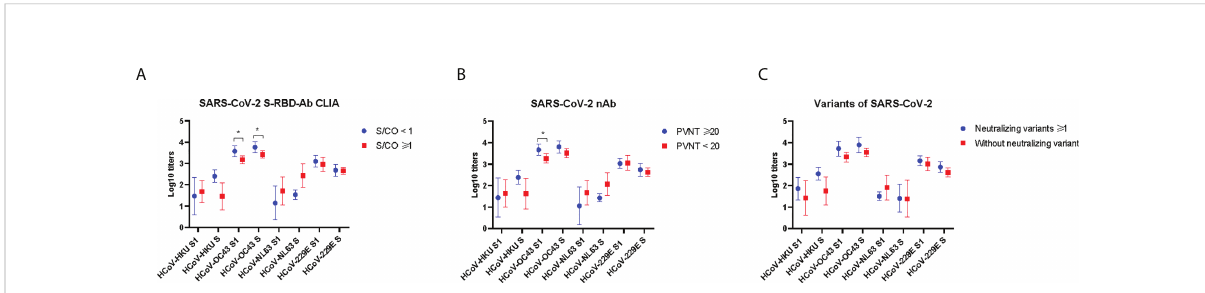
FIGURE 5 Prior antibody to seasonal HCoVs in the groups with and without antibodies to SARS-CoV-2 at 24 weeks after vaccination. The anti-RBD antibody levels were detected by chemiluminescent microparticle immunoassay (A) . The nAb levels were detected by pseudovirus neutralization test (B) , and neutralizing antibodies against authentic SARS-CoV-2 variants (C) . Two-tailed, nonparametric Mann – Whitney test was used for comparisons. The bars display the mean and SD. Part of the results between groups is shown in the fi gure. * p <